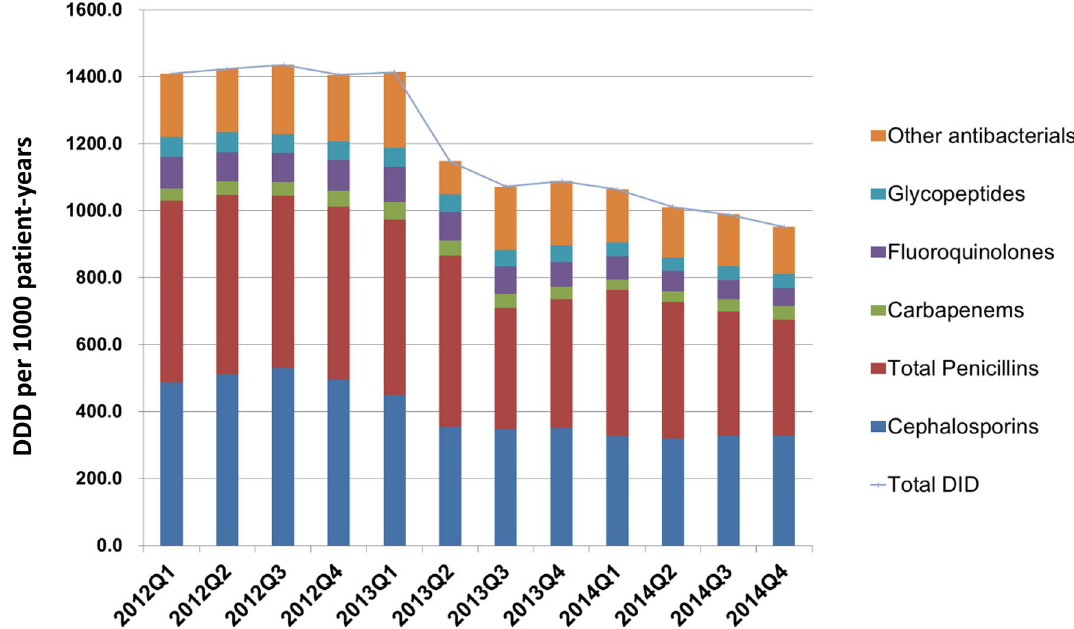
Figure 2. Total antimicrobial consumption of antibiotics before and after the